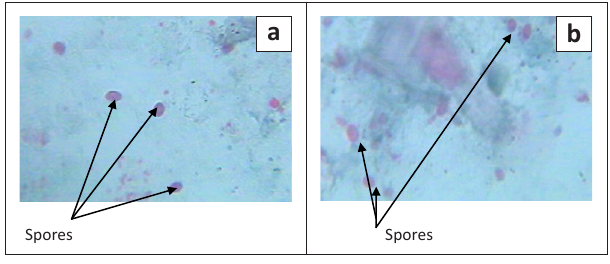
FIGURE 1: Images of Microsporidium spores in stool samples from our study.